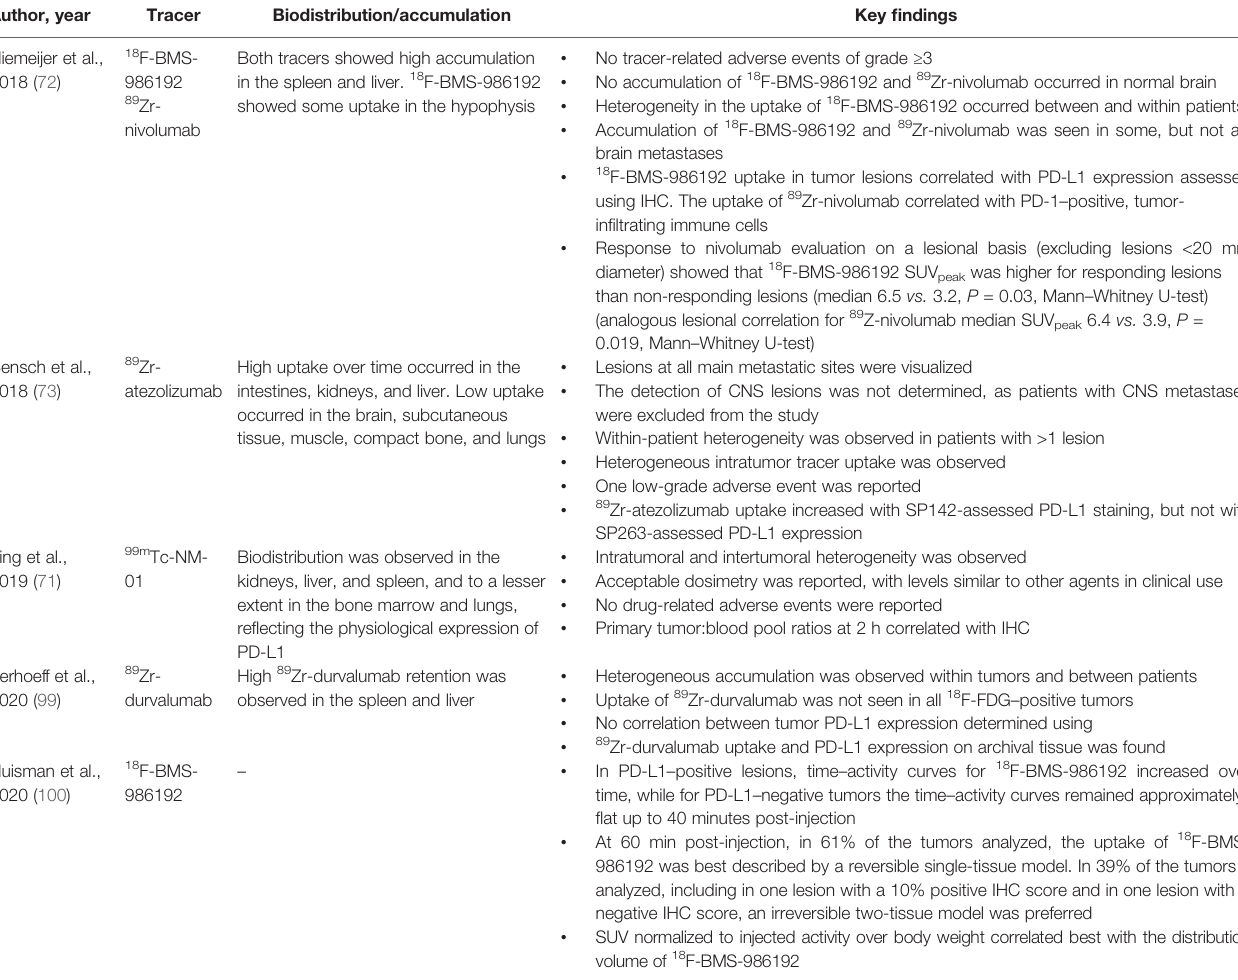
TABLE 1 | Examples of clinically tested PD-(L)1 PET